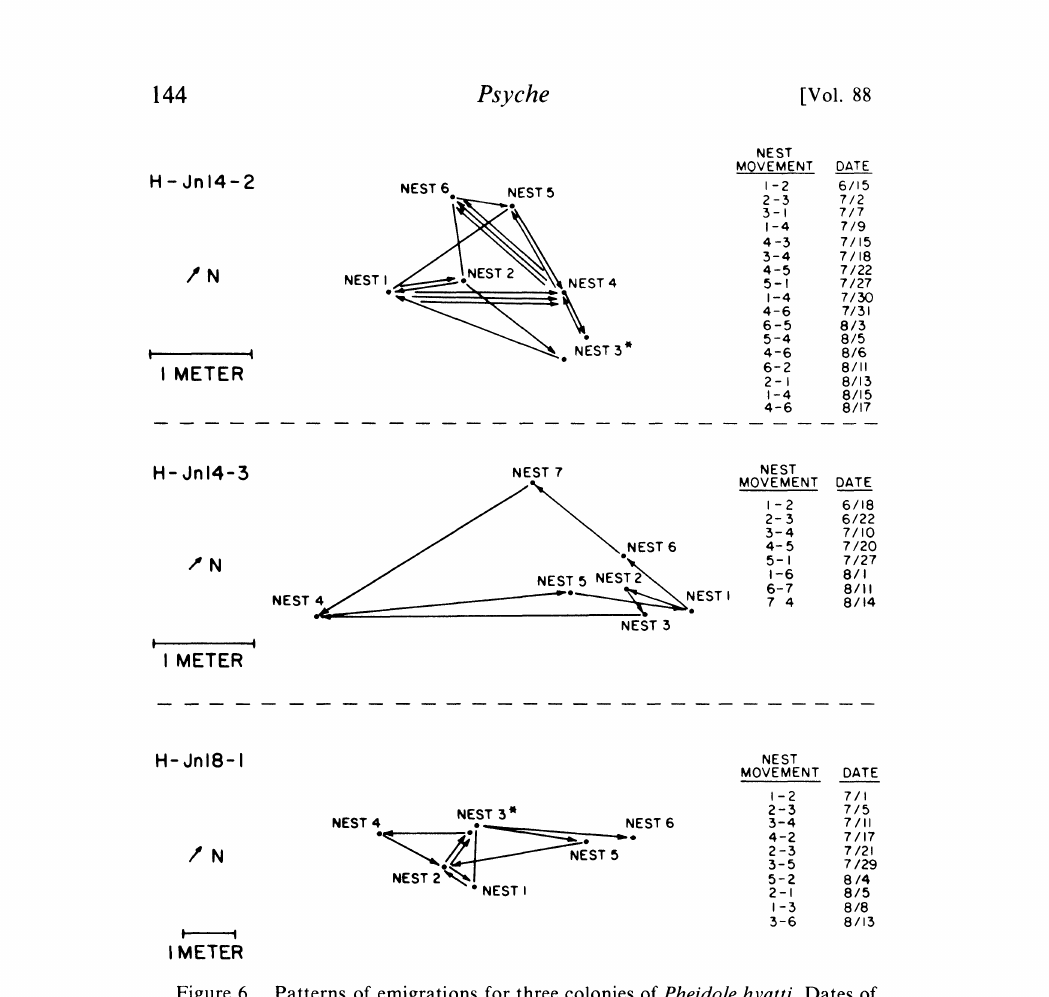
Figure 6. P.atterns of emigrations for three colonies of Pheidole hyatti. Dates of nest movements are shown on the right. *This nest had two entrances. are short-lived. When these nests are disturbed, the colonies quickly organize emigrations to other such nests (H611dobler and Wilson 1977). Leptothorax acervorum in oak-juniper woodland, construct delicate nests under stones which can be easily dislodged by large vertebrates, and are prone to emigrate when their nest is disturbed (MiSglich